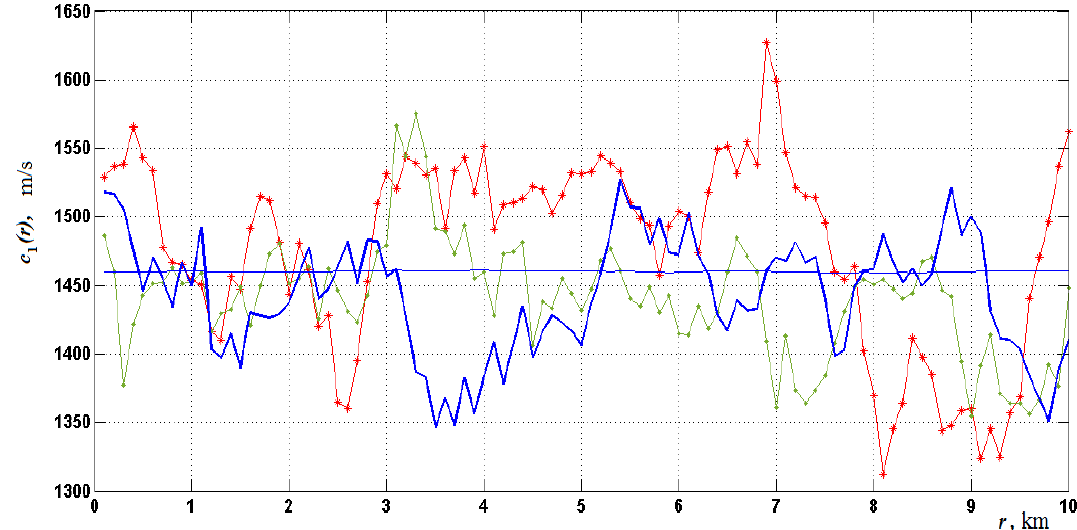
Figure 2. Three arbitrary random realizations of the speed of sound in the bottom half-space from the ensemble of N realizations, L r = 1 km.